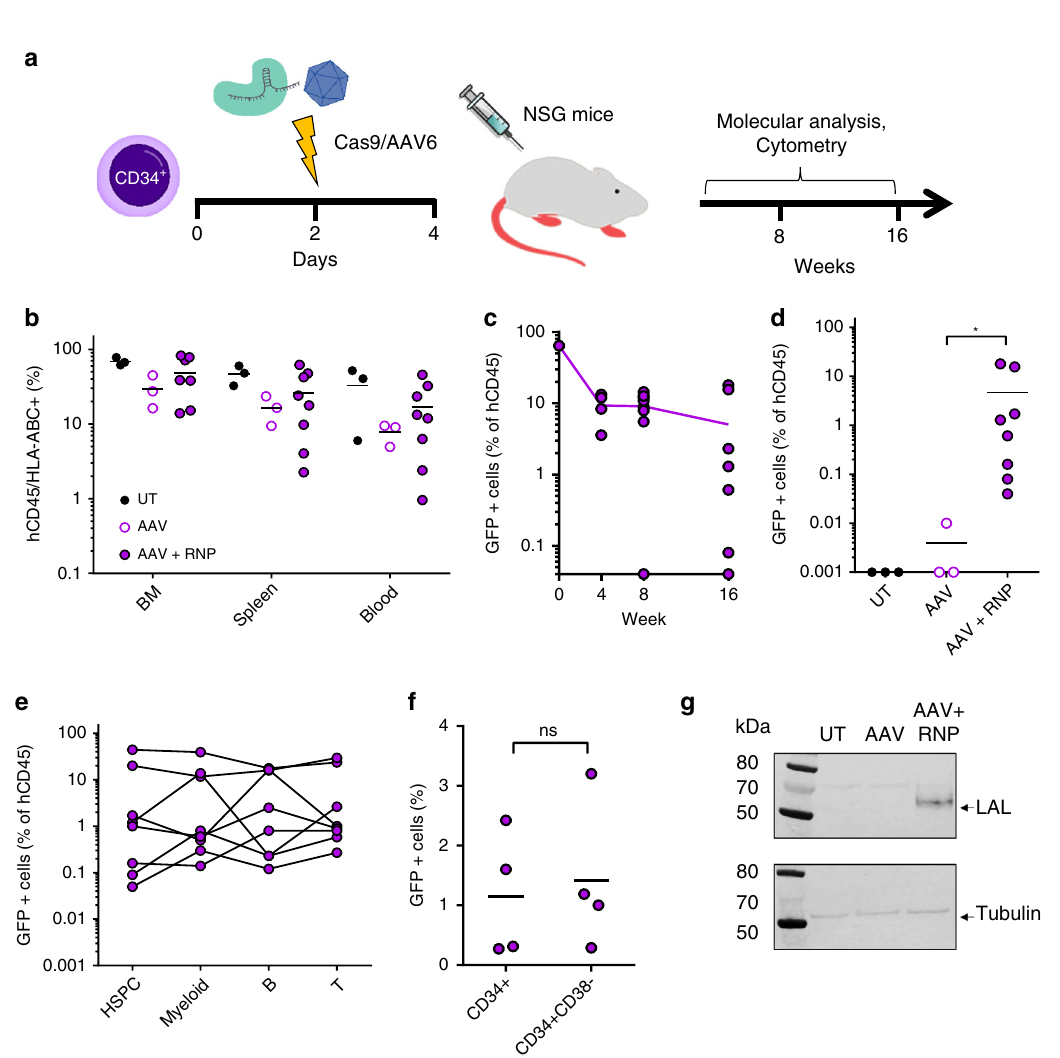
Fig. 5 KI HSPCs engraft NSG mice and express LAL upon erythroid differentiation. a Schematic representation of engraftment experiments. b Percentage of human CD45 + /HLA-ABC + cells in hematopoietic organs of mice. BM = bone marrow. (UT and AAV n = 3; AAV + RNP n = 8). c GFP positive cells in peripheral blood of transplanted mice over time. Line indicates mean ( n = 4 week 4; n = 8 week 8 and 16). d Edited cells in bone marrow of transplanted mice. GFP is expressed as percentage of CD45 + cells, mean is shown (* p = 0.012 AAV vs AAV + RNP, two-tailed Mann – Whitney test). e GFP positive cells in HSPCs (CD34), myeloid (CD33), B (CD19) and T (CD3) cells in bone marrow of transplanted mice. Each line represents one animal ( n = 8). f GFP positive cells in HSPCs (CD34) and in a more primitive HSPC subset (CD34 + CD38 − ) in bone marrow of transplanted mice ( n = 4; ns: p = 0.8, two-tailed Mann Whitney test). g Western blot on CD34-derived BFU-E from mice engrafted with untreated (UT), transduced (AAV) or KI HSPCs (AAV + RNP). Anti-HA tag and anti- β tubulin antibodies were used ( n = 2, BFU-E pooled from 2 mice). Source data are in the Source Data fi